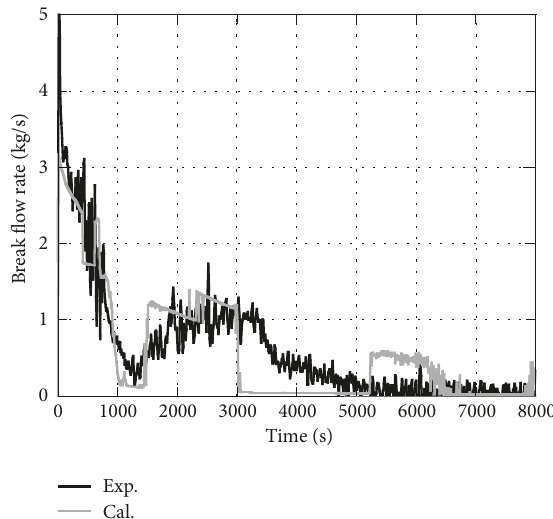
Figure 4: TR-LF-18 test and RELAP5 results for break flow